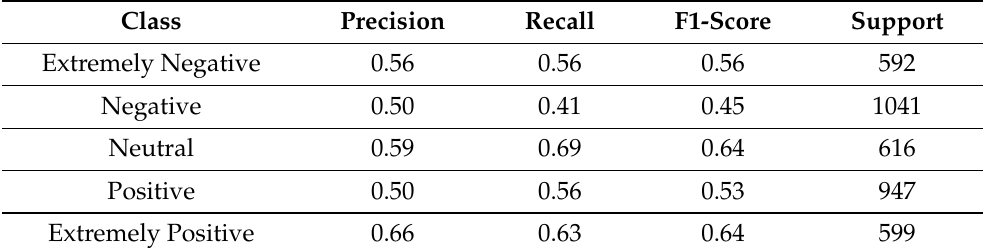
Table 3. Results per class obtained by the logistic model.